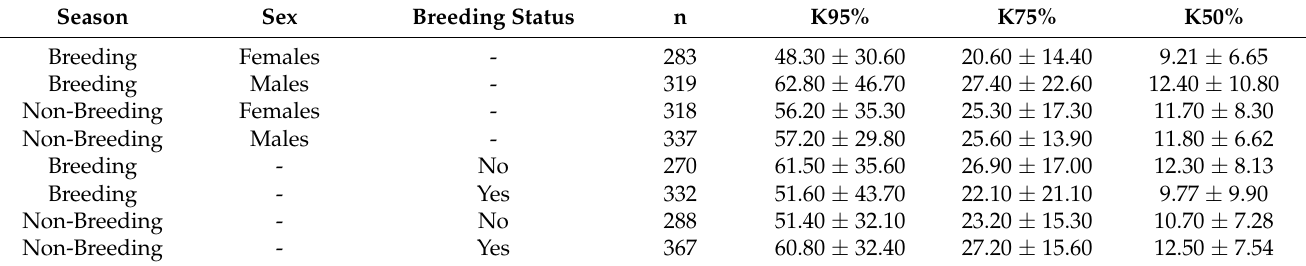
Table 2. Monthly average ( ± standard deviation) daily home-range size (km 2 ) of the three levels (K95%, K75%, and K50%) taking into account “Season”, “Sex”, and “Breeding